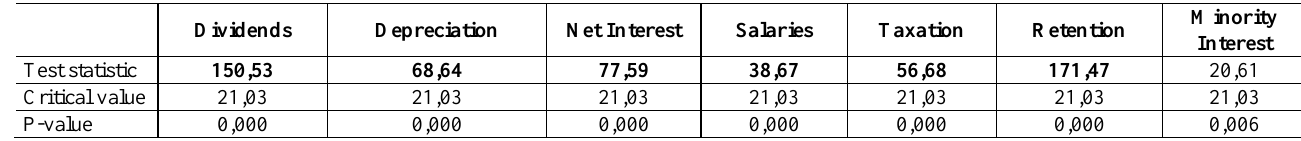
Table 5: Result of Kruskal-Wallis test performed on all VA distribution ratios – full sample